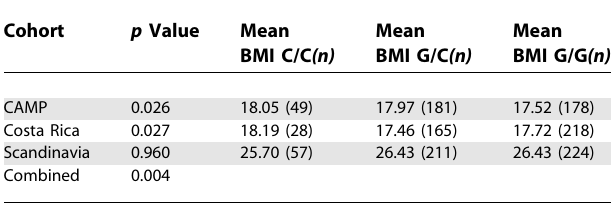
Table 3. Association Studies of rs7566605 C/C Genotype Body Mass Index in Family Cohorts